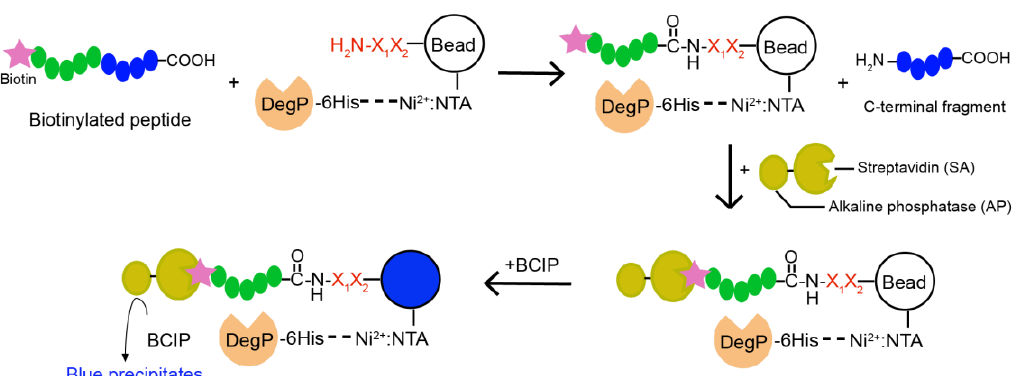
Figure 3. Scheme of the one-bead-one-compound (OBOC)-based approach to find a good nucleophile for the DegP-mediated transpeptidation. Beads are linked to the dipeptide library (X 1 X 2 ) as well as Ni 2+ : NTA, of which the latter recruits the His-tagged DegP on beads. When the N-terminally biotinylated substrate is mixed with the above beads, beads with good nucleophiles may be covalently linked to the N-terminal fragment of the model peptide. The fusion enzyme of streptavidin and alkaline phosphatase binds to these biotinylated beads and the reaction with 5-bromo-4-chloro-3-indoyl-phosphate (BCIP) turns these beads